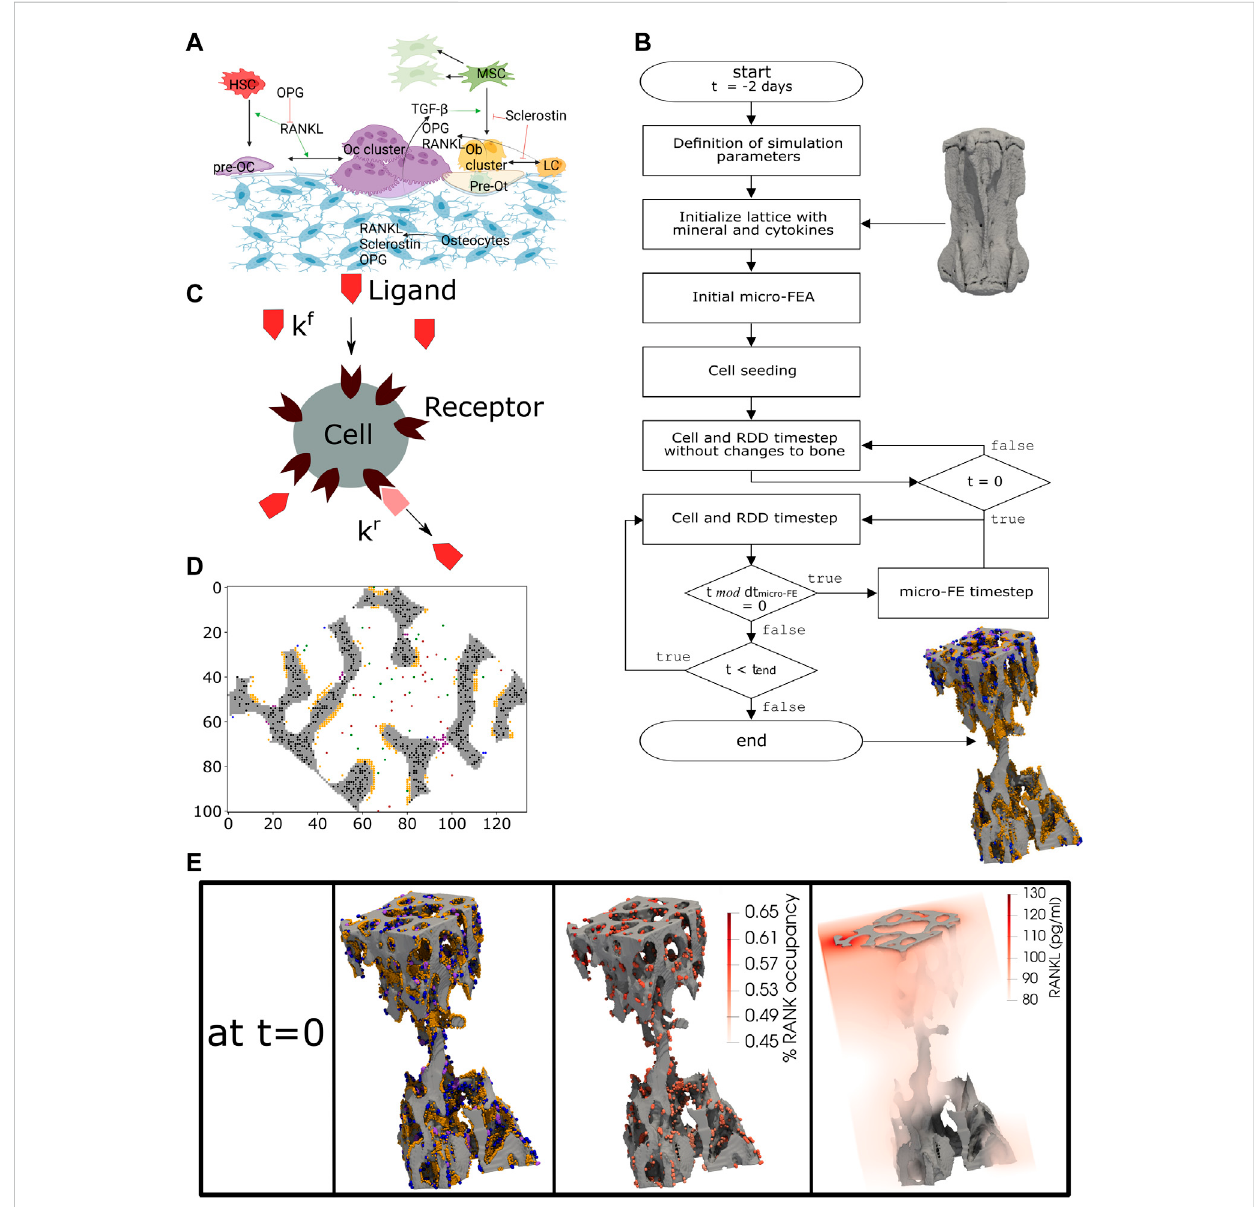
kinetics modeled in silico . Here, the ligand can bind only to the targeted cell receptor with a forward rate k f and it can dissociate from the receptor with a backward rate k r . This is an example of the modeled receptor-ligand kinetics of Lipoprotein receptor-related protein 5/6 (LRP5/6)-sclerostin for an osteoblast, lining cell and mesenchymal stem cell. (D) A 2D slice from the trabecular region of an in silico simulation with osteocytes (black), osteoclasts (purple), preosteoclasts (blue), osteoblasts (orange), mesenchymal stem cells (green) and hematopoietic stem cells (brown). (E) A snapshot of the initial con fi guration of the simulation at t = 0. On the left, the osteoblasts (orange), osteoclasts (purple) and preosteoclasts (blue) are shown on the trabecular bone surface, in the middle the spatial distribution of the receptor activator of nuclear factor kB (RANK) binding site occupancy on the osteoclasts and preosteoclasts and on the right the spatial distribution of the RANK ligand (RANKL) con fi guration in the trabecular region. (A) created with